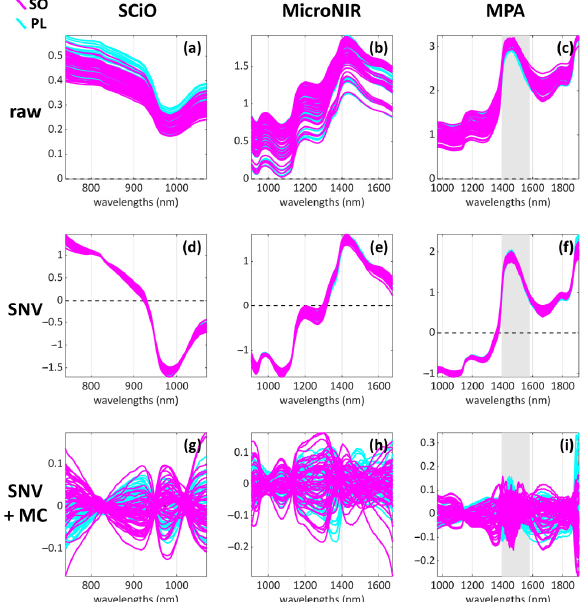
Figure 2. Visual representation of the datasets of the study: ( a – c ) the raw data, ( d – f ) the SNV-pre- processed data and ( g – i ) the SNV and mean centred (MC) data.